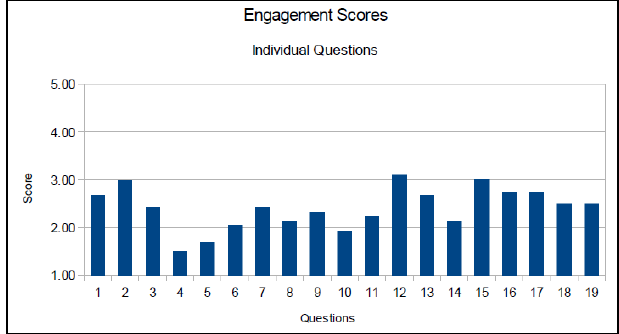
Figure 3. Average scores for the individual questions on the modified GEQ, 1 being the lowest and 5 being the highest